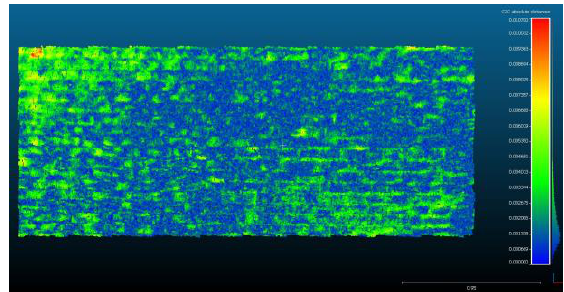
Figure 8. Comparison of the two point clouds in CloudCompare. The average discrepancy is 2.5 mm.